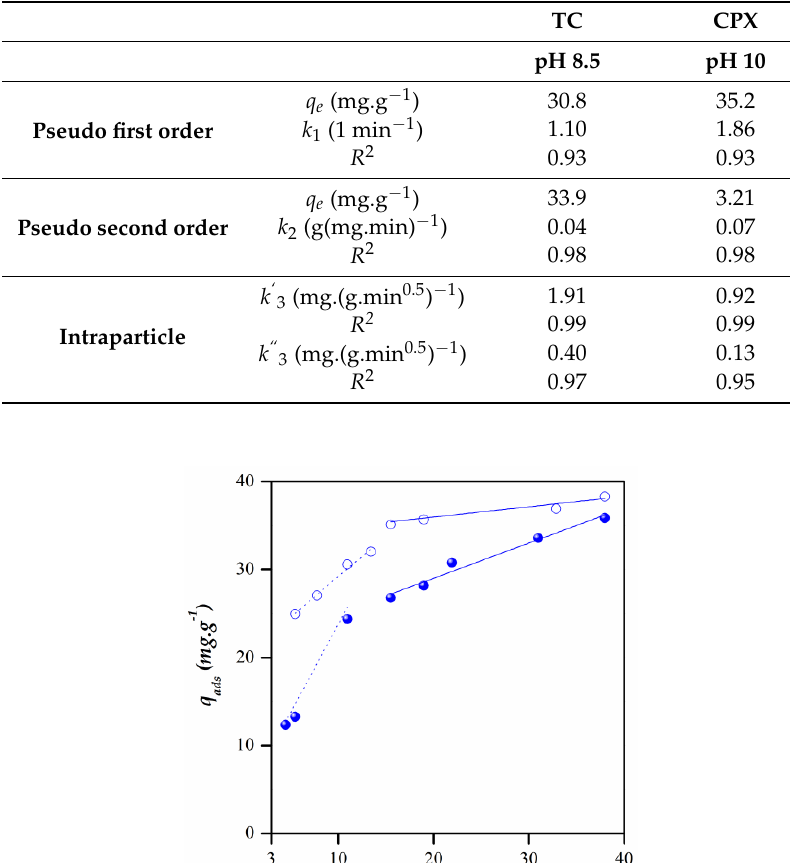
Table 3. Pseudo-first-, -second-order, and intraparticle rate parameters for TC and CPX on Si-PILC 75.